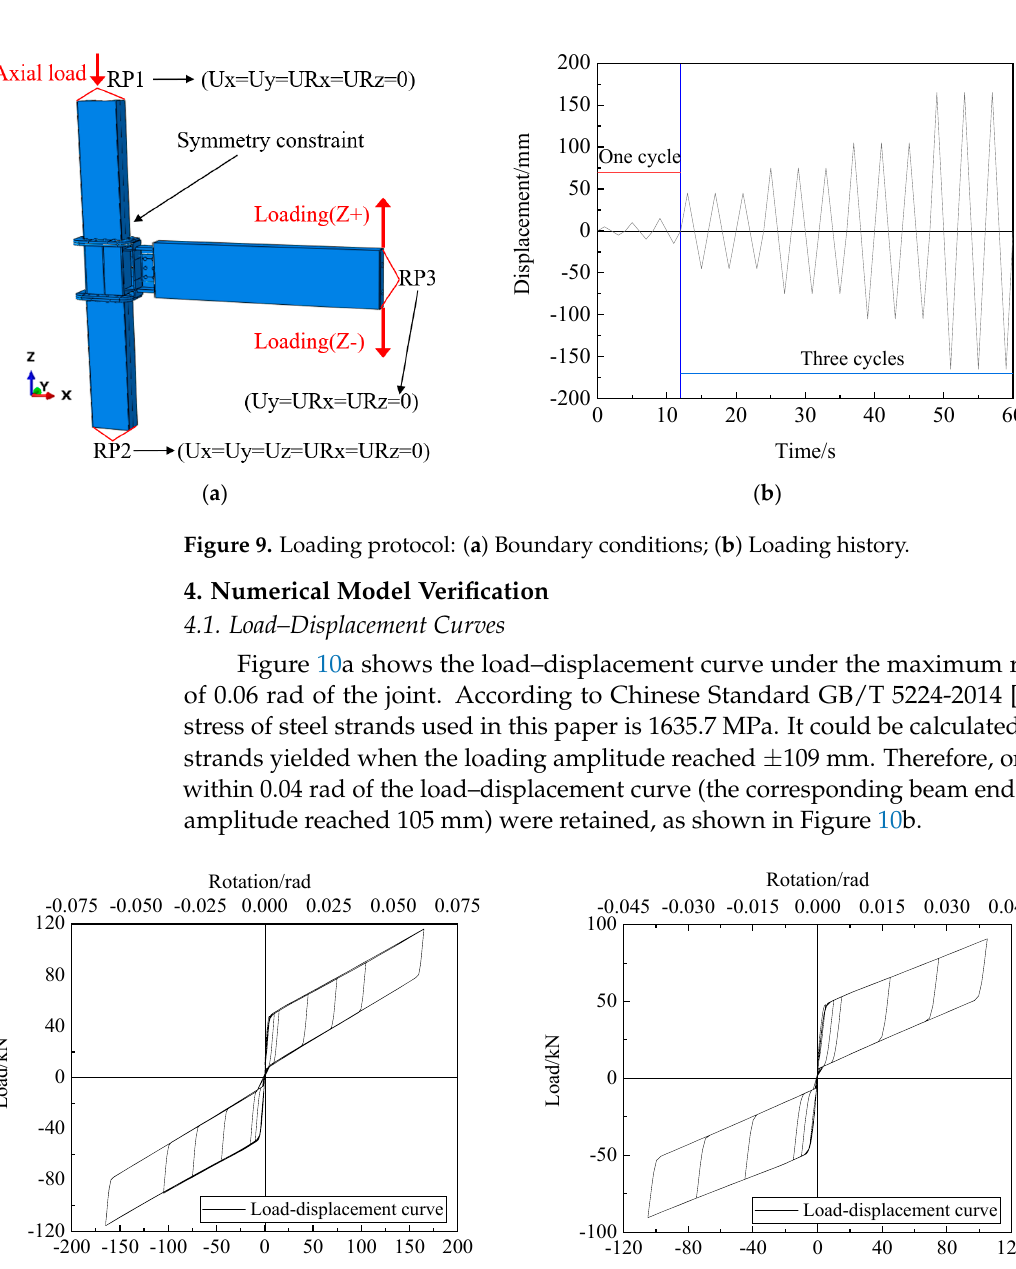
( b ) Figure 8. Meshing of the joint: ( a ) Overview of the joint; ( b ) Details of the joint. 3.3. Interaction and Loading Protocol In the model, contact pairs were adopted to simulate the interaction between compo-